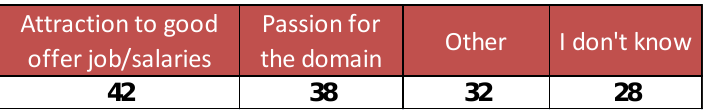
Table 2. Motivations to follow studies outside CS in number of answers. Answers from the